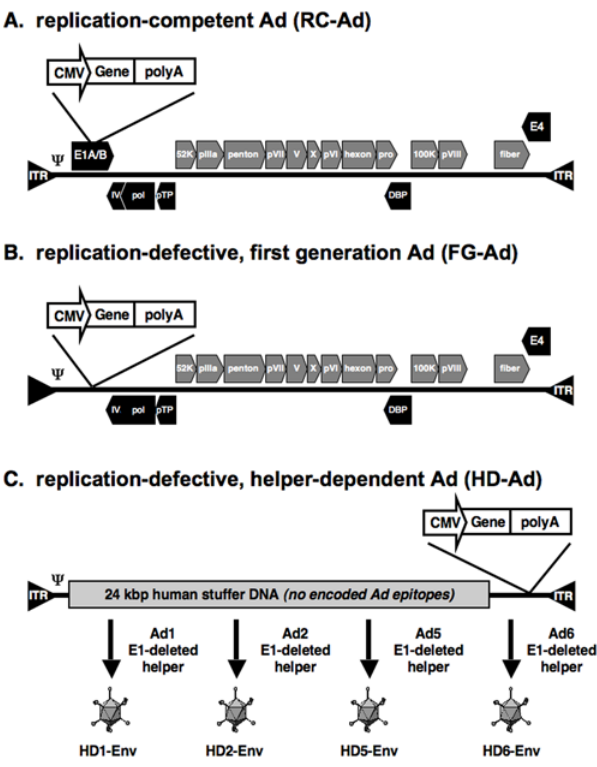
Figure 1. Schematic representation of adenovirus genome organization for replication-competent (A), First-Generation (B), and Helper-Dependent (C) viruses.